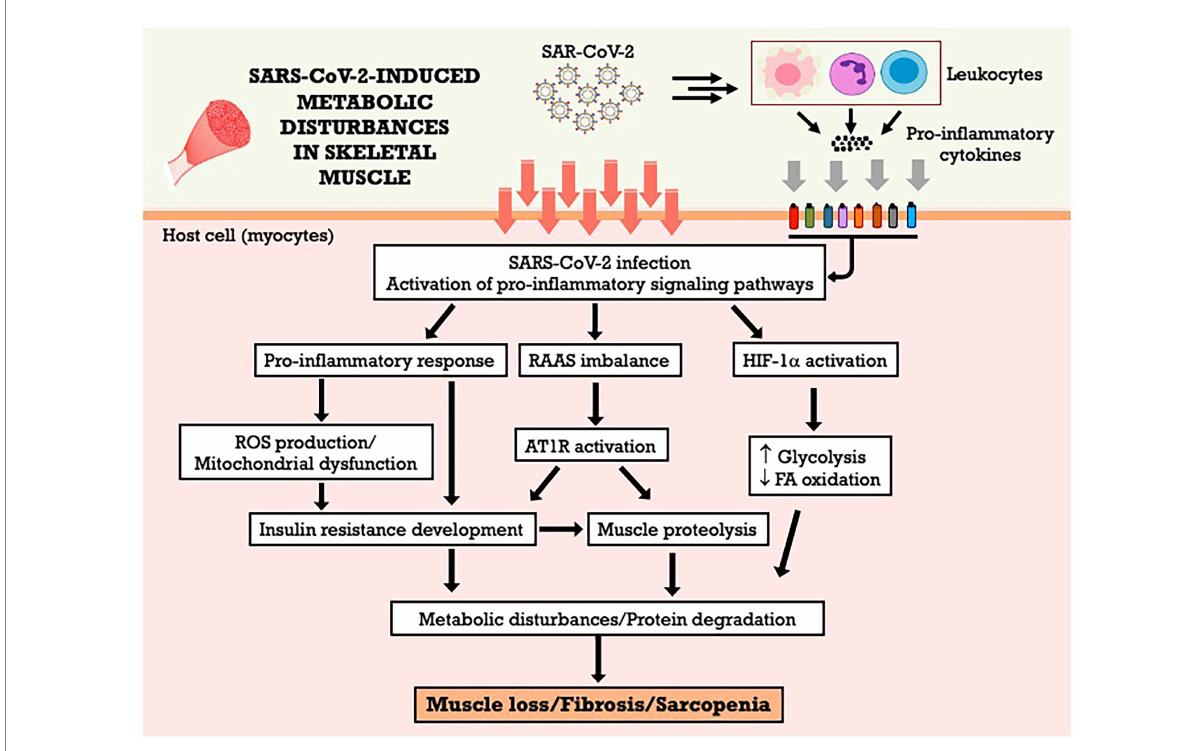
FIGURE 2 SARS-CoV-2-induced metabolic disturbances in skeletal muscle. AT1R, angiotensin II type 1 receptor; FA, fatty acid; HIF-1 α , hypoxia-inducible factor-1 alpha; RAAS, renin-angiotensin-aldosterone system; ROS, reactive oxygen